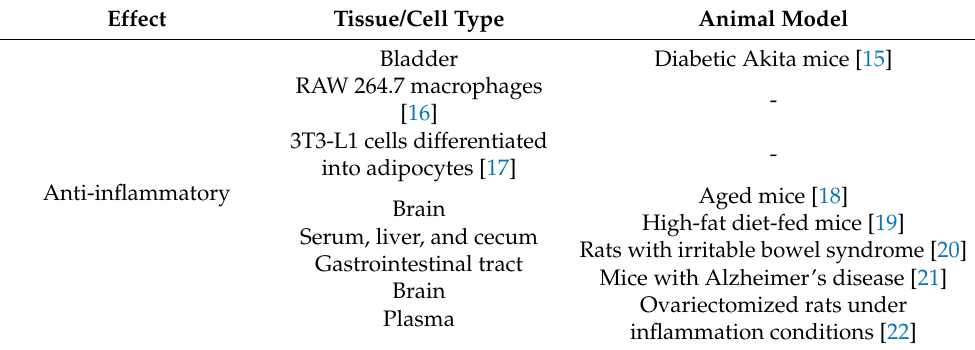
Table 1. Main phlorizin’s effects described in the bibliography beyond glycosuria and the improve- ment of insulin